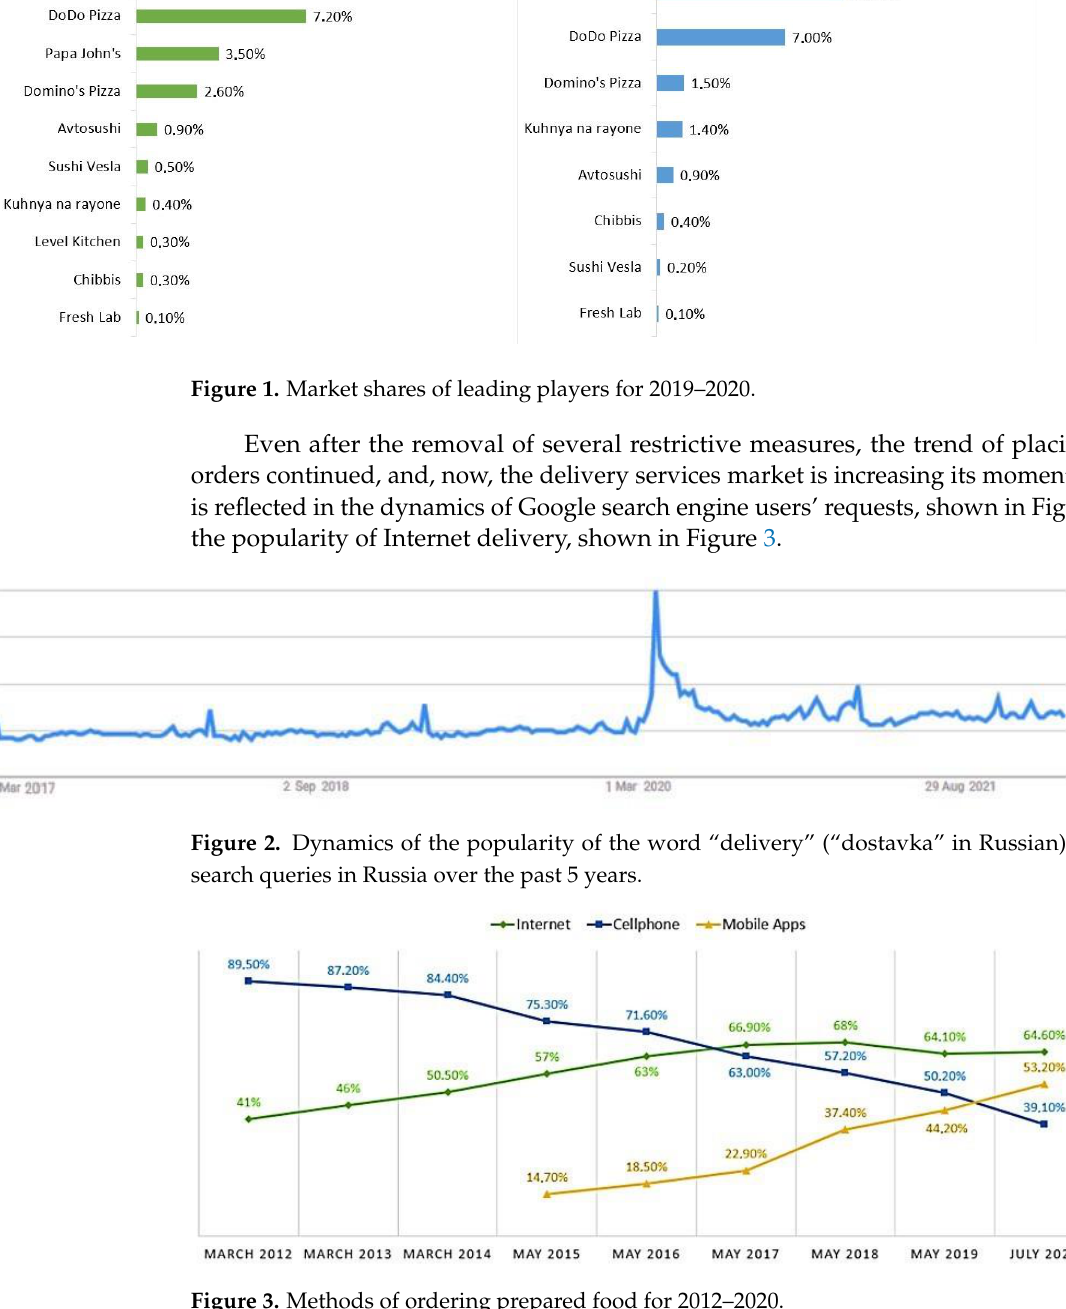
Figure 3. Methods of ordering prepared food for 2012 – 2020.